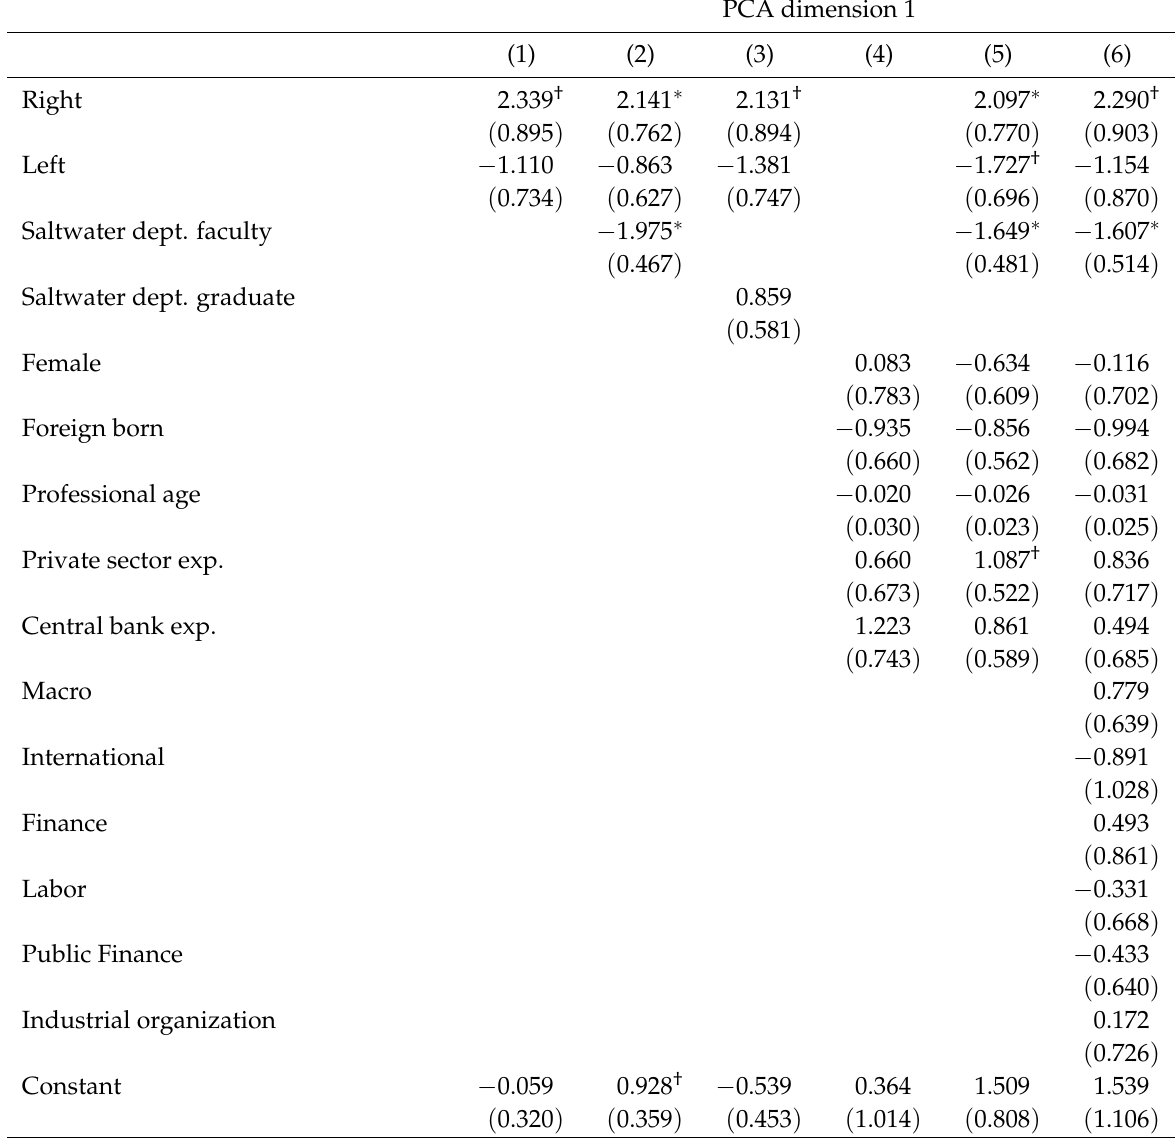
Table 2: Linear models of respondents’ latent